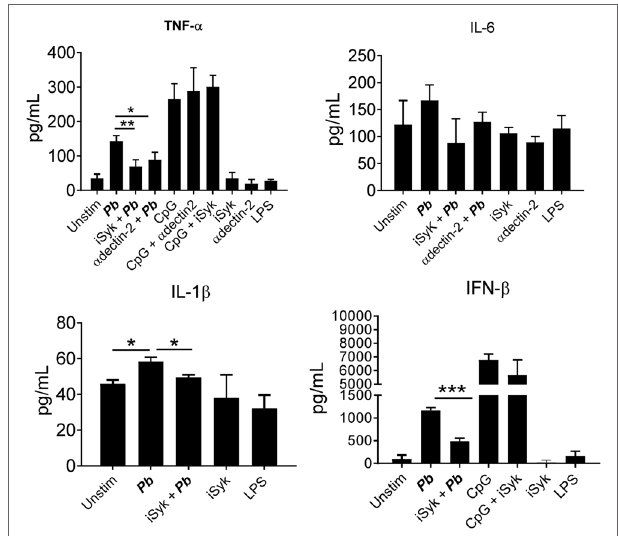
FigUre 6 | Dectin-2/Syk signaling controls the secretion of cytokines by Paracoccidioides brasiliensis stimulated plasmacytoid dendritic cells (pDCs). Peripheral blood mononuclear cells were separated into pDC-positive populations (pDCs + ) using magnetic beads conjugated to anti-CD304 antibodies. The pDCs (1 × 10 5 /well) were challenged overnight with of P. brasiliensis yeast cells (2 × 10 3 ). Some wells were kept only with the yeasts, CpG (100 ng/mL), or LPS (10 ng/mL). Some cultures were treated with anti-dectin-2 antibody (100 µg/mL) or with a Syk pathway inhibitor, piceatannol (10 µM), before challenging with P. brasiliensis yeast cells. After 18 h of culture, the plates were centrifuged and the supernatant was collected for cytokines measurements by ELISA. Data are represented by the means ± SE of the average cytokine concentrations from four donors, tested in duplicate. *** p < 0.001 and * p < 0.05 comparing the data indicated by the